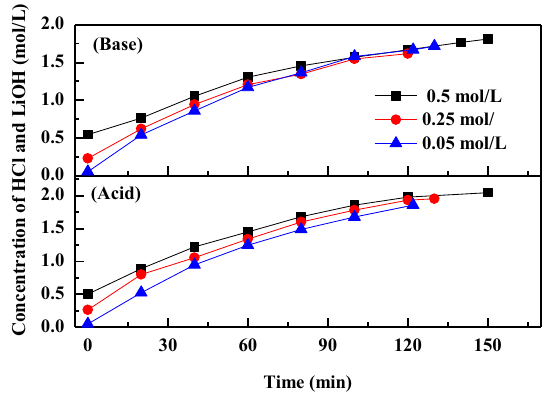
Fig. 7 Effect of initial acid and base concentration on generation of HCl and